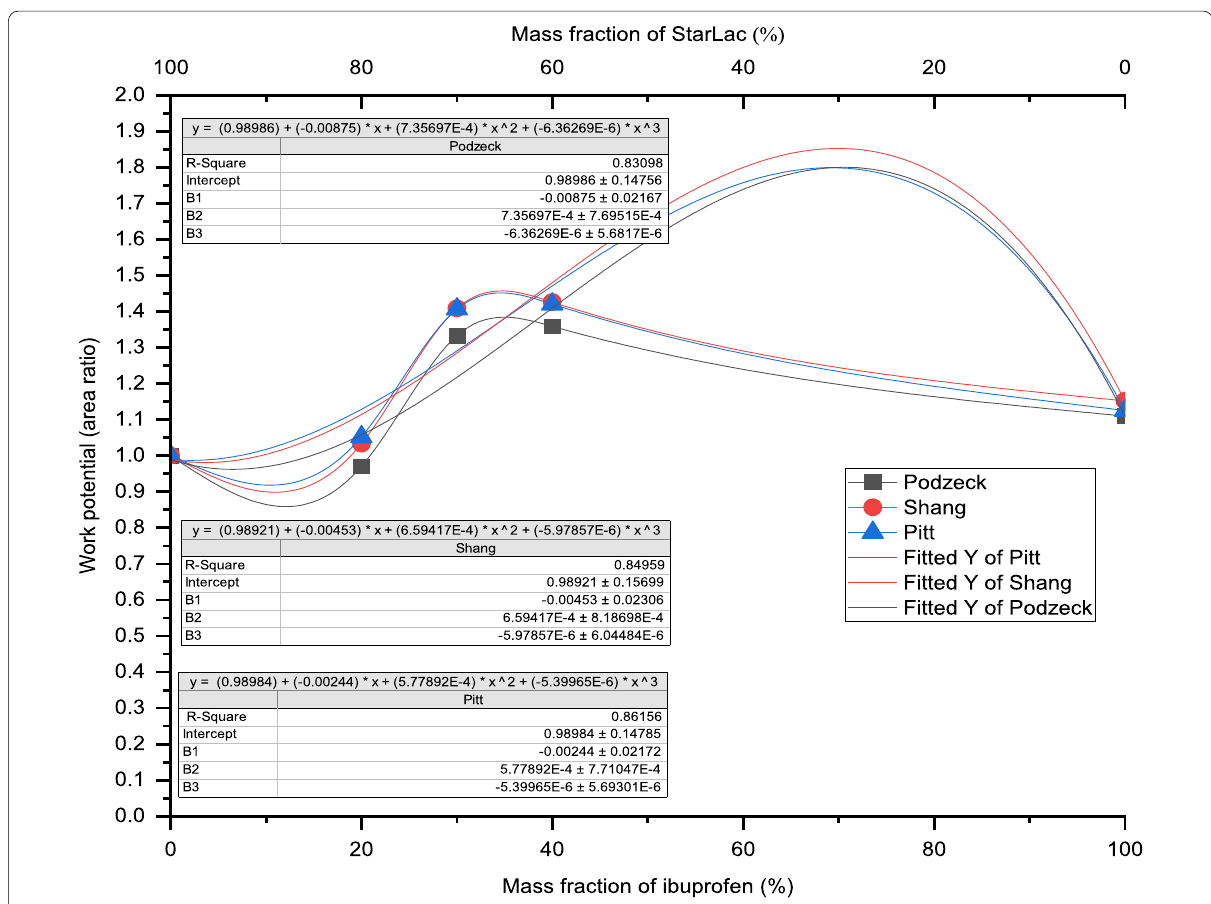
Fig. 9 Third-order polynomial fitting of area ratio-mass fraction data. StarLac ® was the reference